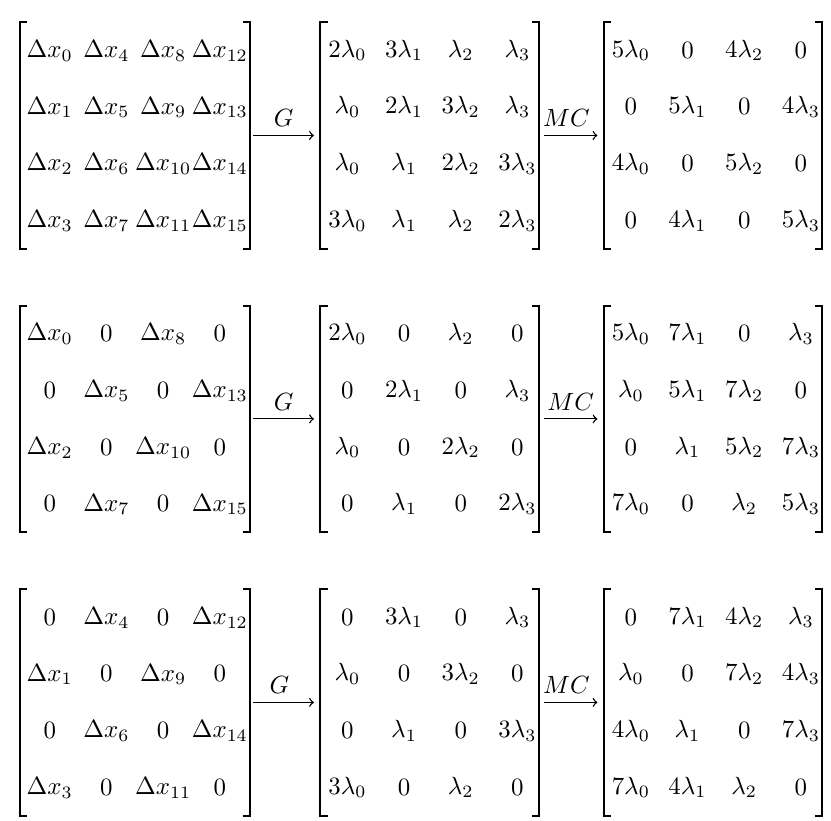
Figure 3: 2-round related differential trails starting with ∆ x , ∆ x 0 and ∆ x ⊕ ∆ x 0